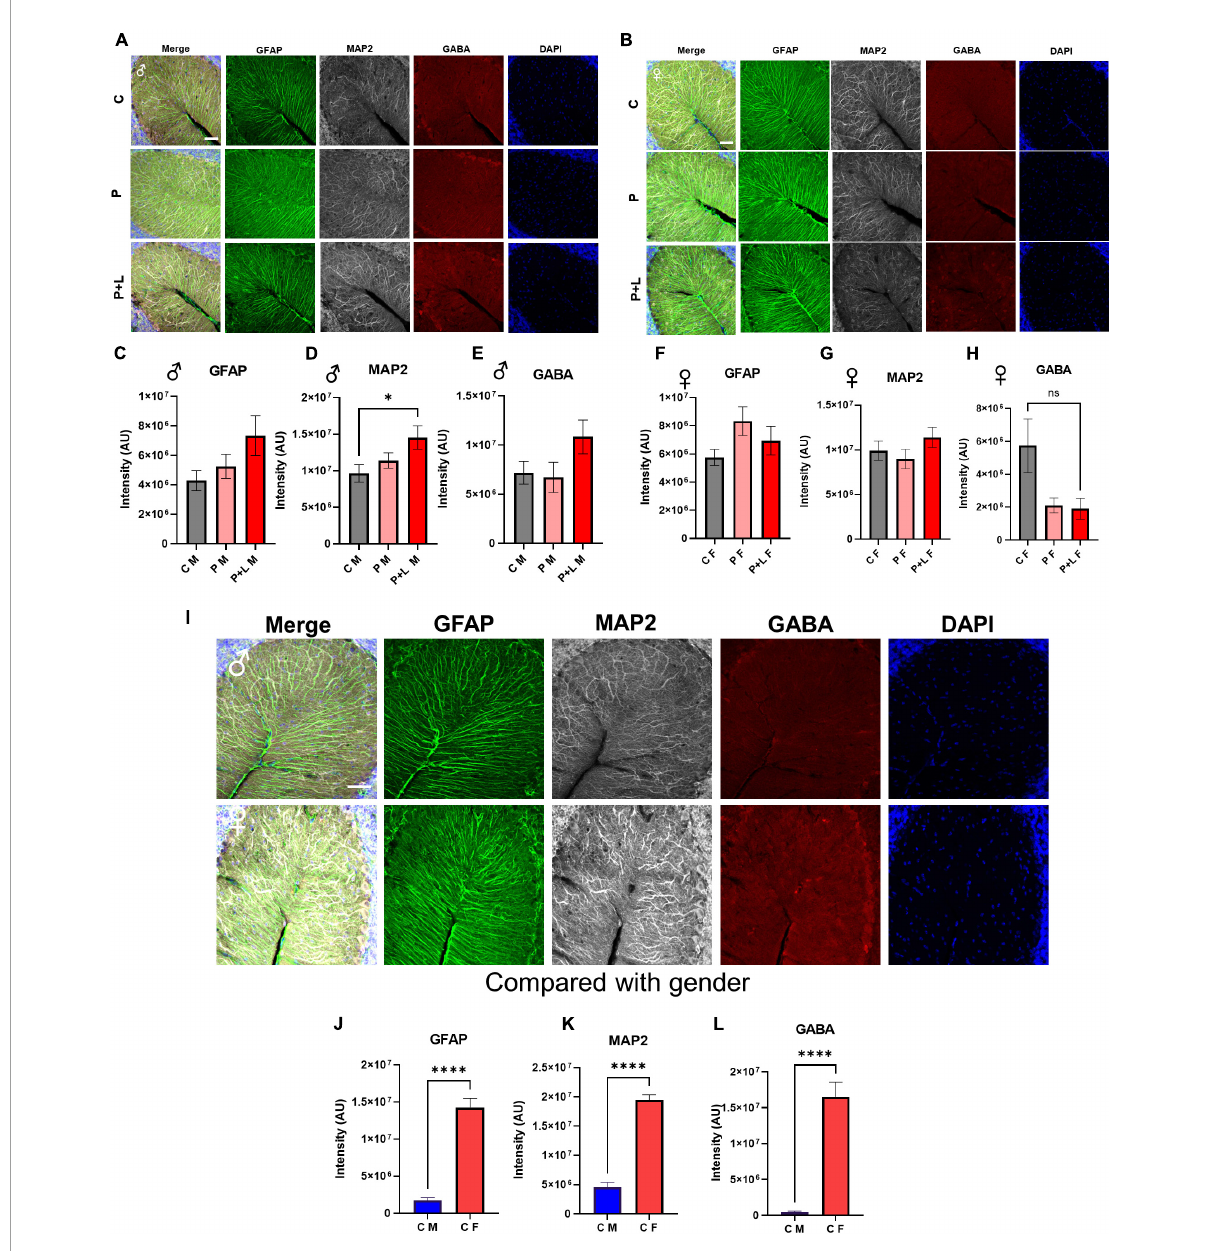
FIGURE6 Decreased GABA level in male offspring by low-level lead exposure (A,B) Representative images for the cerebellar staining with the astrocyte (GFAP), neuron (MAP2), GABA (GABA), and nucleus (DAPI). Scale bars, 50 µ m. (A) Male. (B) Female. (C–E) Statistical analysis of male mouse. (C) GFAP, (D) MAP2, (E) GABA. Data were analyzed with one-way ANOVA and expressed as mean ± SEM. N = 3. ∗ p < 0.05. (F–H) Statistical analysis of female mouse. (F) GFAP, (G) MAP2, (H) GABA. Data were analyzed with one-way ANOVA and expressed as mean ± SEM. N = 3. (I) Representative figures for the cerebellar staining compared by the gender. Male (upper) and female (lower) . (J–L) Statistical analysis of the comparison with gender graph. (J) GFAP, (K) MAP2, (L) GABA. Data were analyzed with Mann–Whitney test to compare two groups, expressed as mean ± SEM. N = 3, ∗∗∗∗ p <